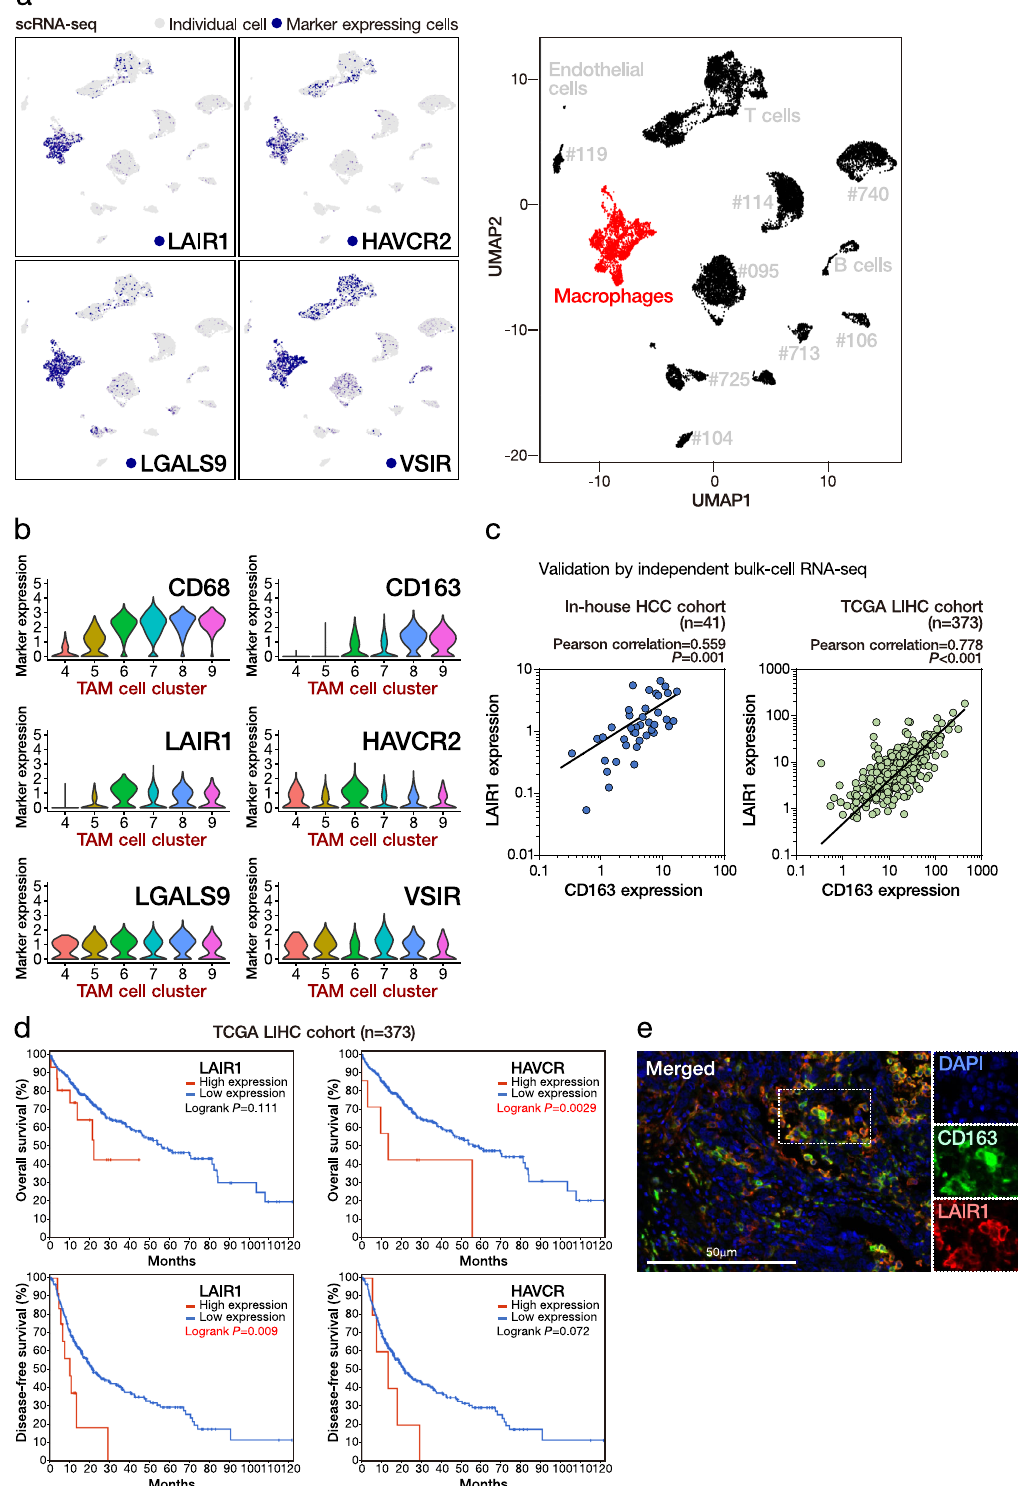
Fig. 2 High expression of TAM markers in HCC tumors suggests poor prognosis. a TAMs had enriched expression for multiple immunosuppressive markers. b TAM cell clusters expressing cancer-promoting M2 macrophage marker CD163 had concurrent enrichment for LAIR1 expression. c Expressions of CD163 and LAIR1 were signi fi cantly correlated in both in-house and TCGA datasets. Student ’ s t test (two-sided). d High expressions of LAIR1 and HAVCR2 were signi fi cant associated with poorer disease-free and overall survivals, respectively. Log-rank test (two-sided). e Overlap of the LAIR1 and M2 macrophages (CD163) using multicolor immuno fl uorescence staining in Case #713. Scale bar = 50 µ m. More than ten fi elds each under ×40 and ×100 magni fi cation were examined. Source data are provided as a Source Data fi